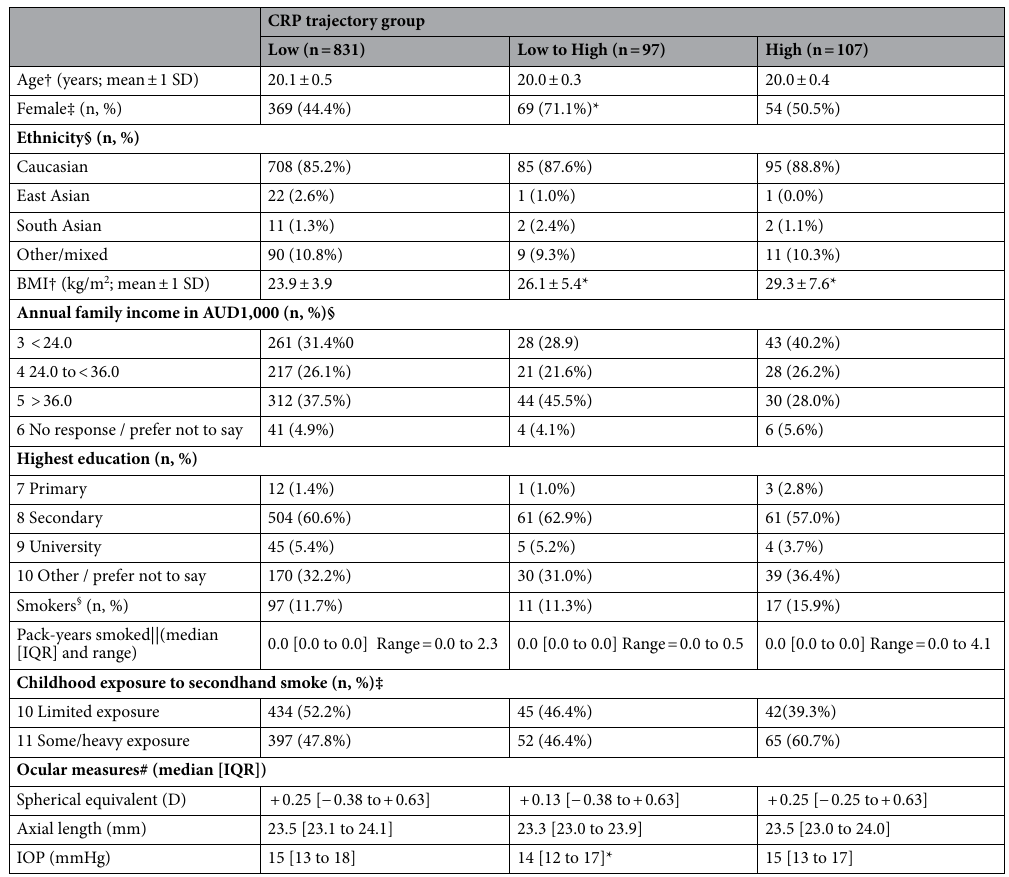
Table 3. Study sample characteristics for retinal thickness analyses (n = 1036). BMI = body mass index; CRP = c-reactive protein; IOP = intraocular pressure; IQR = interquartile range; SD = standard deviation. *Statistically different from the “Low” group at p < 0.001; †group difference analysed using one-way analysis of variance; ‡analysed using Chi-squared test; §analysed using Fisher exact test; ||range additionally shown as median and IQR values are all 0, analysed using the using the Kruskal–Wallis test; #analysed using generalised estimating